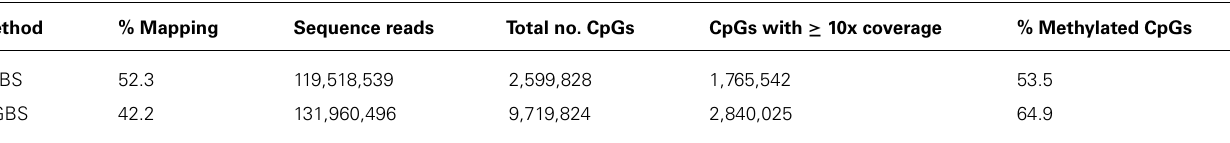
Table 2 | Mapping efficiencies, CpG coverage and average genome-wide methylation levels resulting from reduced representation bisulfite sequencing (RRBS) and whole genome bisulfite sequencing (WGBS) libraries.